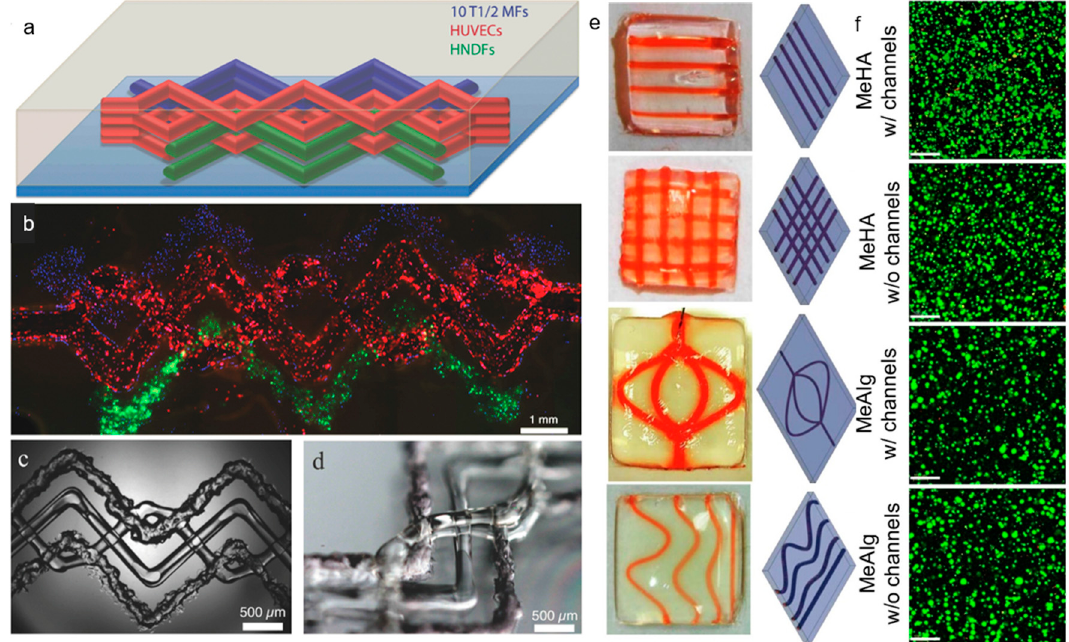
Figure 8. Vascular channels using extrusion-based bioprinting. ( a ) Schematic view of a